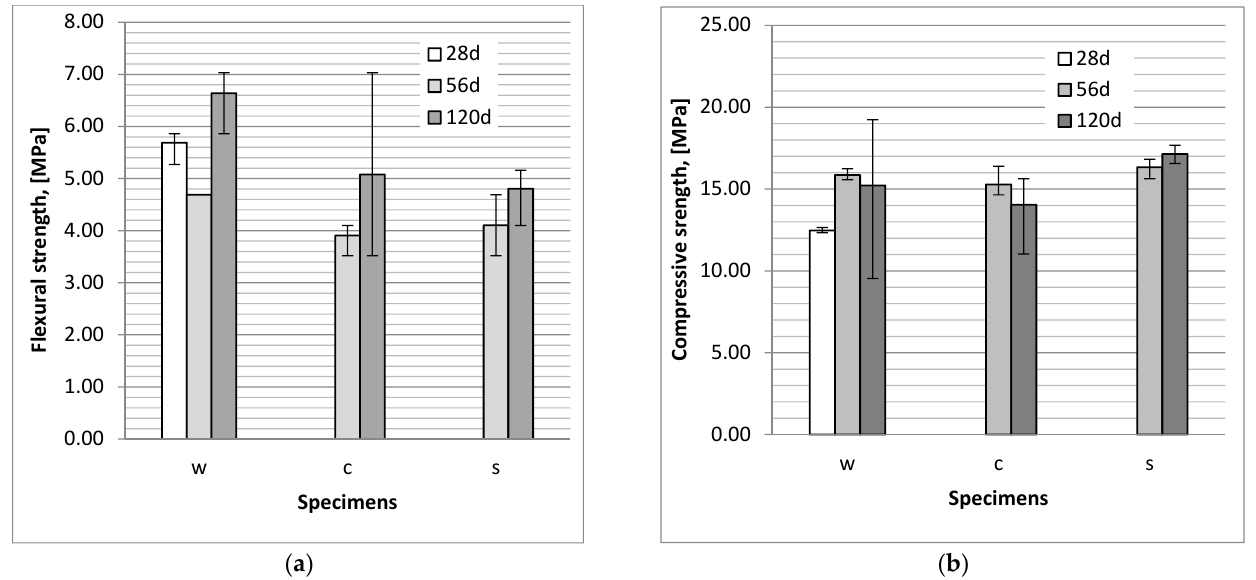
Figure 2. Flexural ( a ) and compressive ( b ) strength of slag-fly ash binder bars; w—specimens stored in tap water, c— specimens stored in a NaCl solution, s—specimens stored in a Na 2 SO 4 solution.